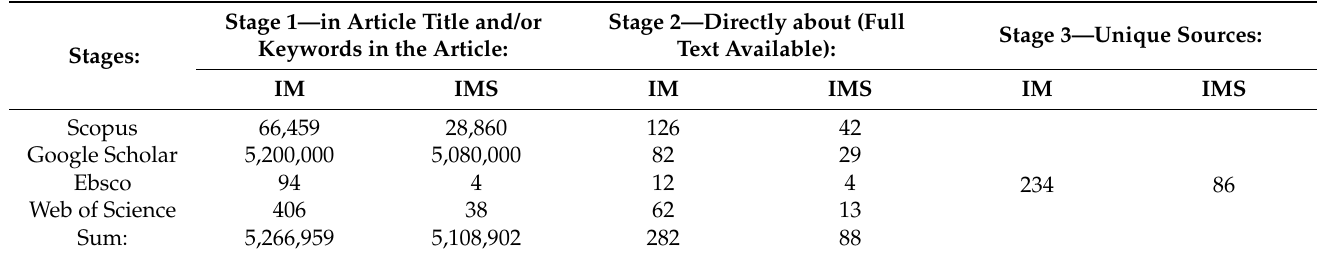
Table 1. Idea management literature review.